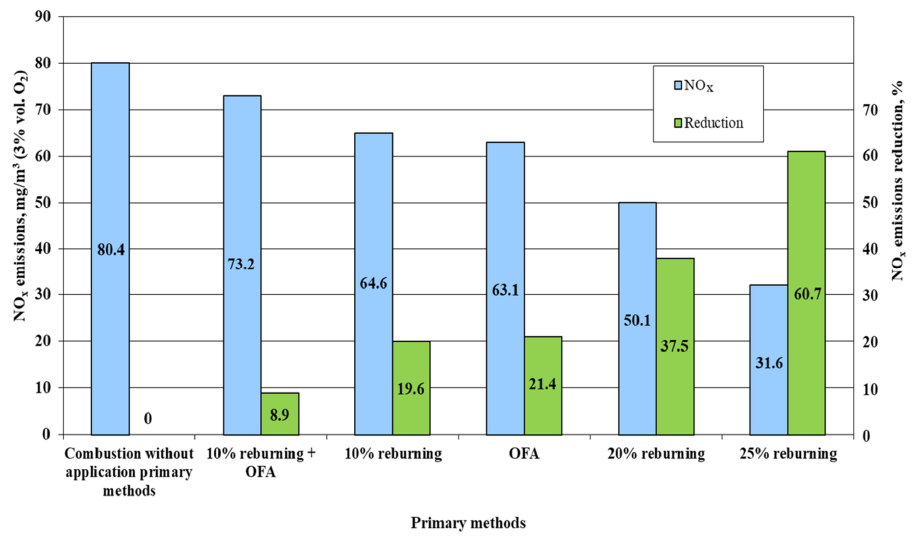
Figure 2. Nitrogen oxide emissions (expressed in mg / m 3 at 3% vol. oxygen in dry flue gas under normal temperature and pressure) and their reduction after the application of reburning and overfire air methods at total fuel input Q = 1.5 m 3 / h and air excess coe ffi cient m =